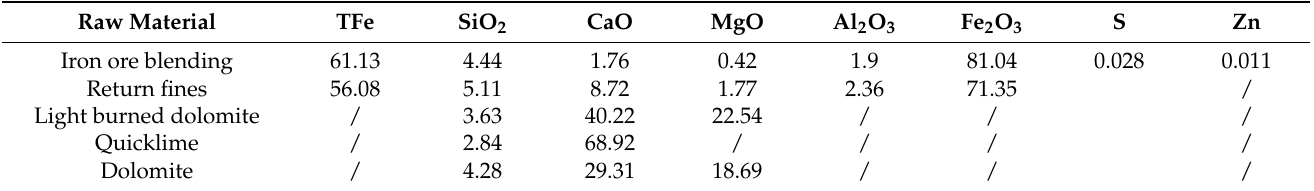
Table 1. Main chemical compositions of iron ore blend and fluxes (mass fraction, mass %).